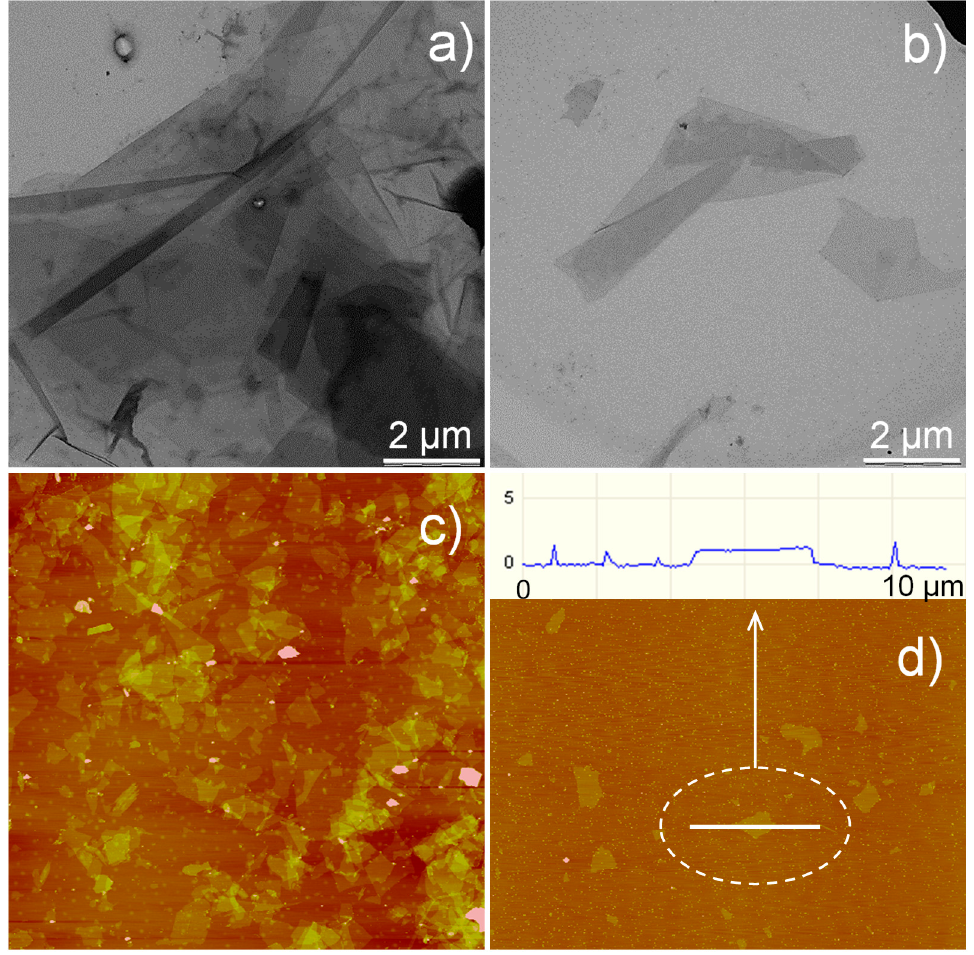
Figure 1. Transmission electron microscopy (TEM) images of mica nanosheets at ( a ) 0.2 wt % and ( b ) 0.02 wt %. Atomic force microscopy (AFM) height images of mica nanosheets: ( c ) at 0.2 wt % and 20 × 20 µ m 2 ; ( d ) at 0.02 wt % and 40 × 40 µ m 2 .